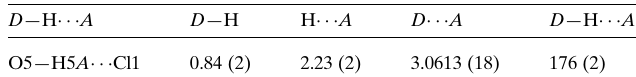
Table 2 Hydrogen-bond geometry (A˚ , (cid:4) ).